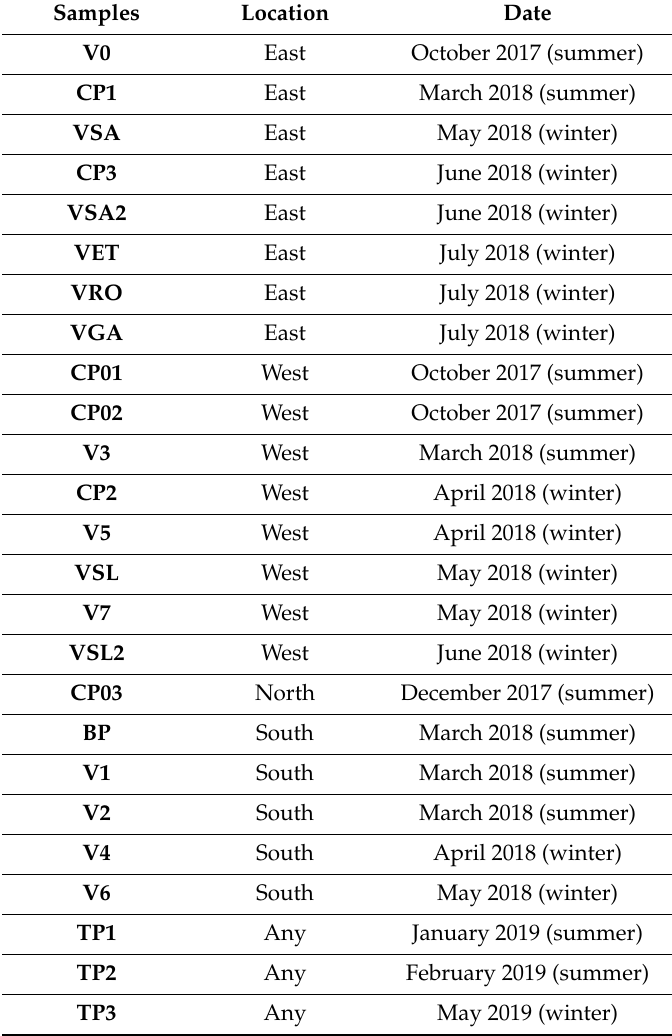
Table 1. Pineapple sample names, sampling location and month of sampling